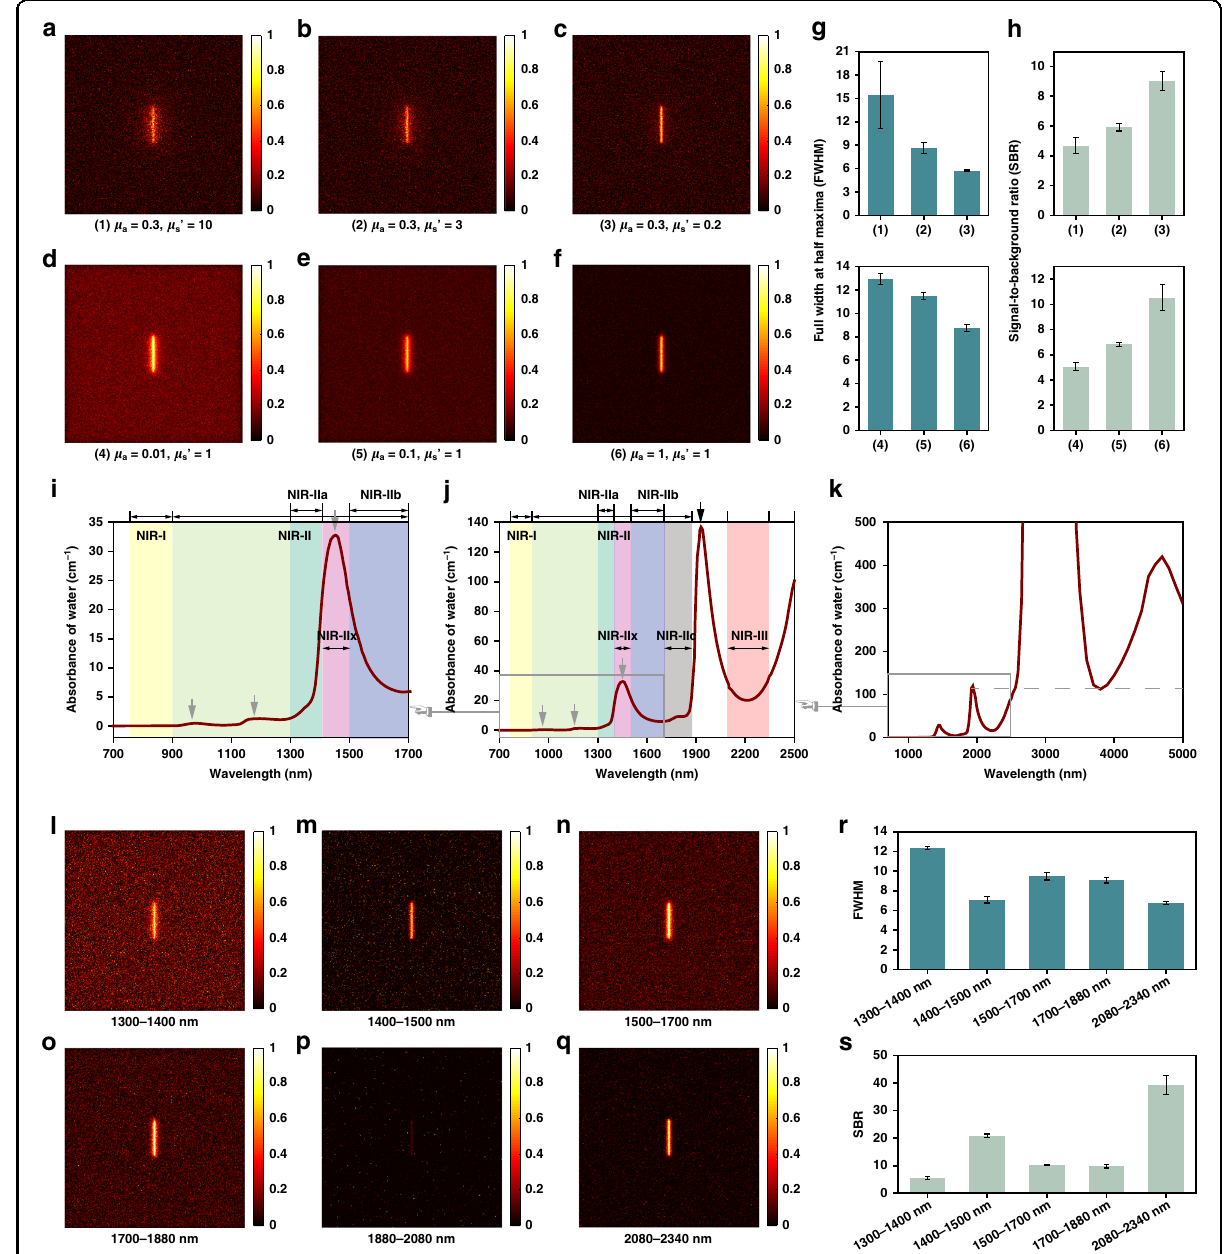
Fig. 2 The simulation results of NIR bio-tissue imaging via the Monte Carlo method. Images of a line source through a bio-tissue of 1-mm thickness with scattering anisotropy factor ( g ) of 0.9, absorption coef fi cient ( μ a ) of 0.3 mm − 1 , and varying reduced scattering coef fi cient ( μ s ’ ) ( a ) μ s ’ = 10 mm − 1 , ( b ) μ s ’ = 3 mm − 1 and ( c ) μ s ’ = 0.2 mm − 1 . Images of a line source through a bio-tissue of 1 mm thickness with g of 0.9, μ s ’ of 1 mm − 1 and varying absorption coef fi cient ( d ) μ a = 0.01 mm − 1 , ( e ) μ a = 0.1 mm − 1 , and ( f ) μ a = 1 mm − 1 . The ( g ) FWHM and ( h ) SBR analyses of the samples in ( a – f ). The light absorption spectra of water within ( i ) 700 – 1700 nm 38 , ( j ) 700 – 2500 nm 38 , and ( k ) 900 – 5000 nm 39 . The gray arrows pointed out the absorption peaks and the gray dashed line in ( k ) represented the absorbance at 1930 nm. Equivalent images of a line source through a bio-tissue of 1 mm thickness in ( l ) 1300 – 1400 nm, ( m ) 1400 – 1500 nm, ( n ) 1500 – 1700 nm, ( o ) 1700 – 1880 nm, ( p ) 1880 – 2080 nm, and ( q ) 2080 – 2340 nm. The ( r ) FWHM and ( s ) SBR analyses of the samples in ( l – q